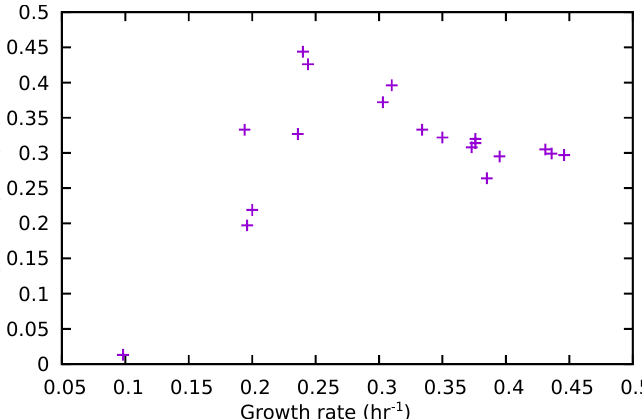
Figure 5. Relationship between calculated specific growth rate ( µ ) and carrying capacity